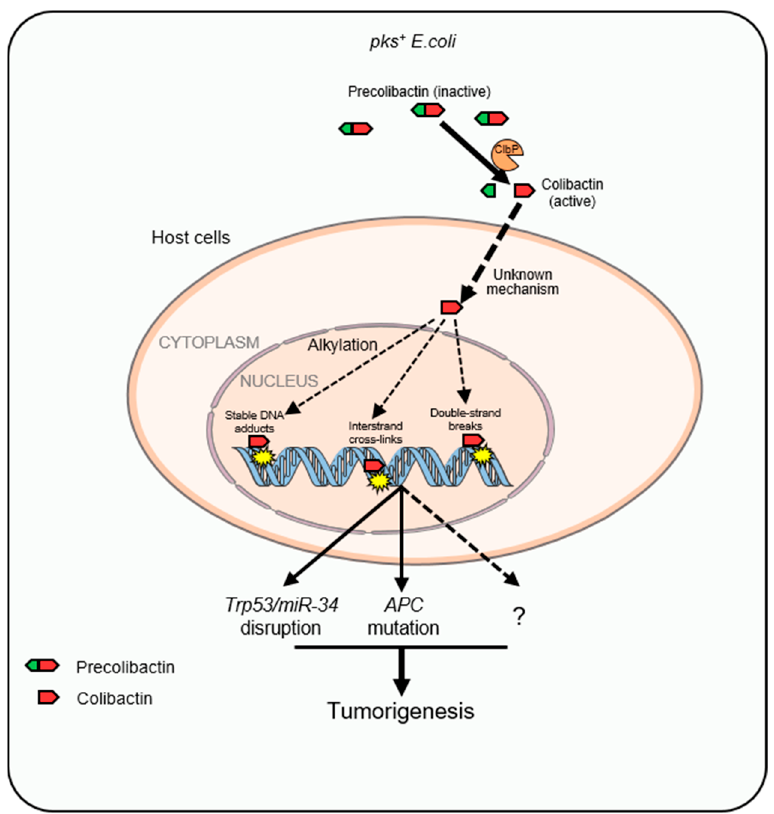
Figure 3. The carcinogenic mechanisms of pks + E. coli -produced colibactin. Mature colibactin, produced by pks + E. coli after peptidase ClbP-mediated cleavage, is translocated into the nucleus of host cells, then alkylates chromatin DNA and causes specific DNA lesions including double-stranded DNA breaks, stable DNA adducts, and interstrand cross-links. Colibactin-induced DNA insults have been associated with CRC susceptibility.